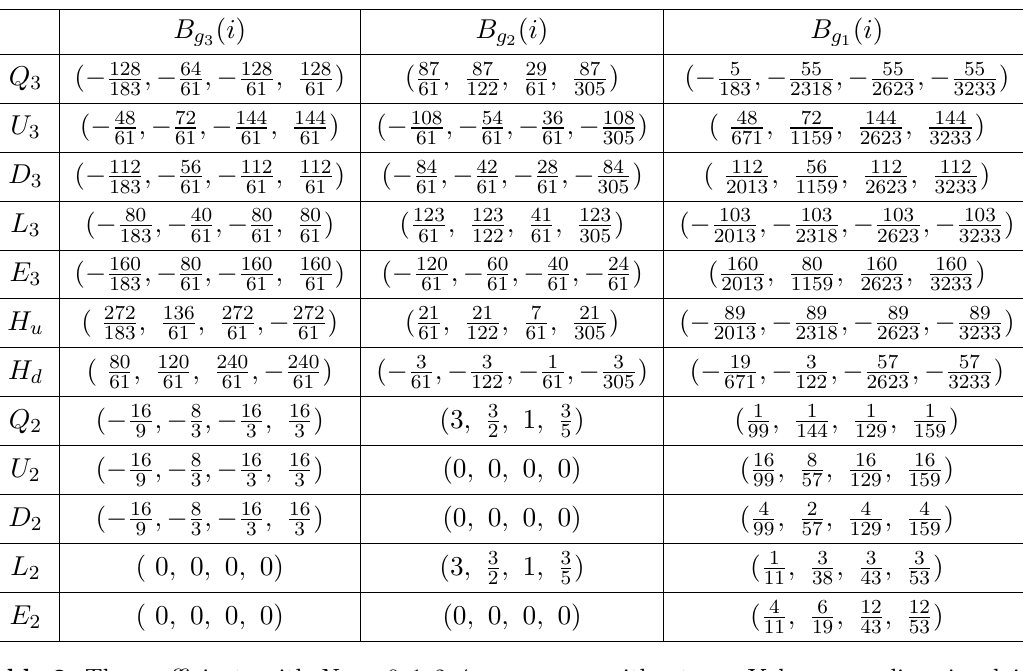
Table 2 . The coe(cid:14)cients with N F = 0 ; 1 ; 2 ; 4 messengers without new Yukawa couplings involving the messengers-matter interactions. The coe(cid:14)cients for y t ; y b ; y (cid:28) , namely A 1 ( y t ), A 2 ( y b ), A 3 ( y (cid:28) ), are the same as the case N F =